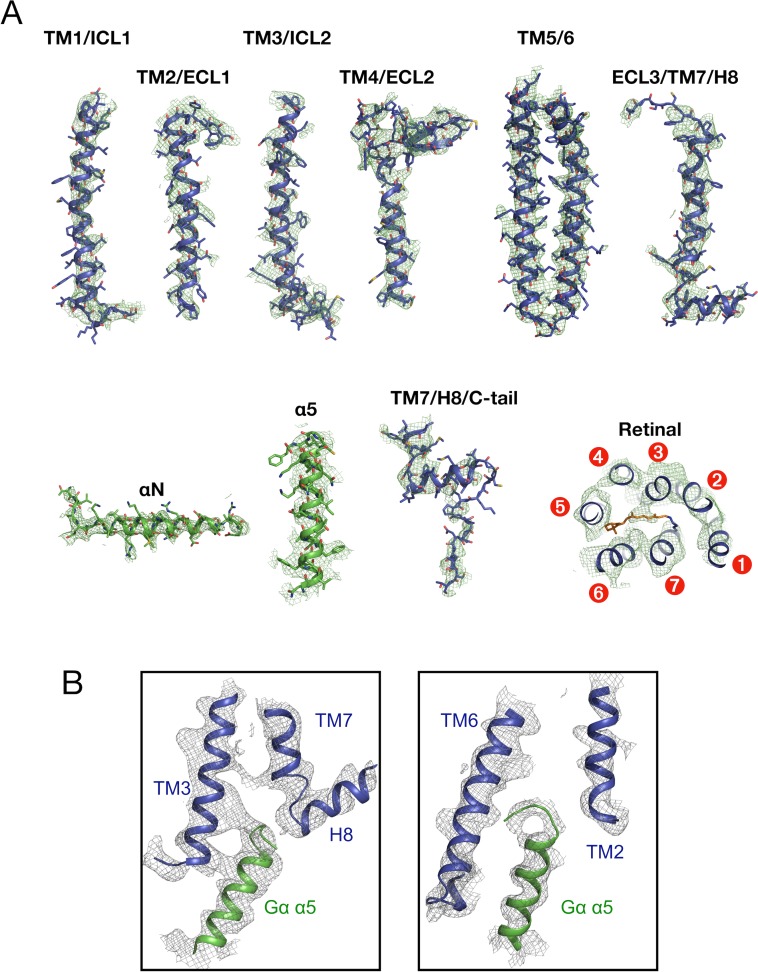
Details of the cryo-EM density map of rhodopsin-Gi-Fab16 with a fitted atomic model.(A) The segmented density map shows individual regions of rhodopsin (transmembrane helices (TM), intracellular and extracellular loops (ICL, ECL), helix 8 (H8) and the C-terminal tail (C-tail), retinal-binding pocket; rhodopsin – blue, retinal – orange) and Gαi (αN and α5 helices, Gαi in green). Atoms are colored by type (nitrogen – blue; oxygen – red; sulfur – dark yellow). (B) Binding interface between the α5 helix of Gαi (in green) and the TM helices of rhodopsin (in blue). The maps are plotted at a 10 σ cuf-off using Pymol.